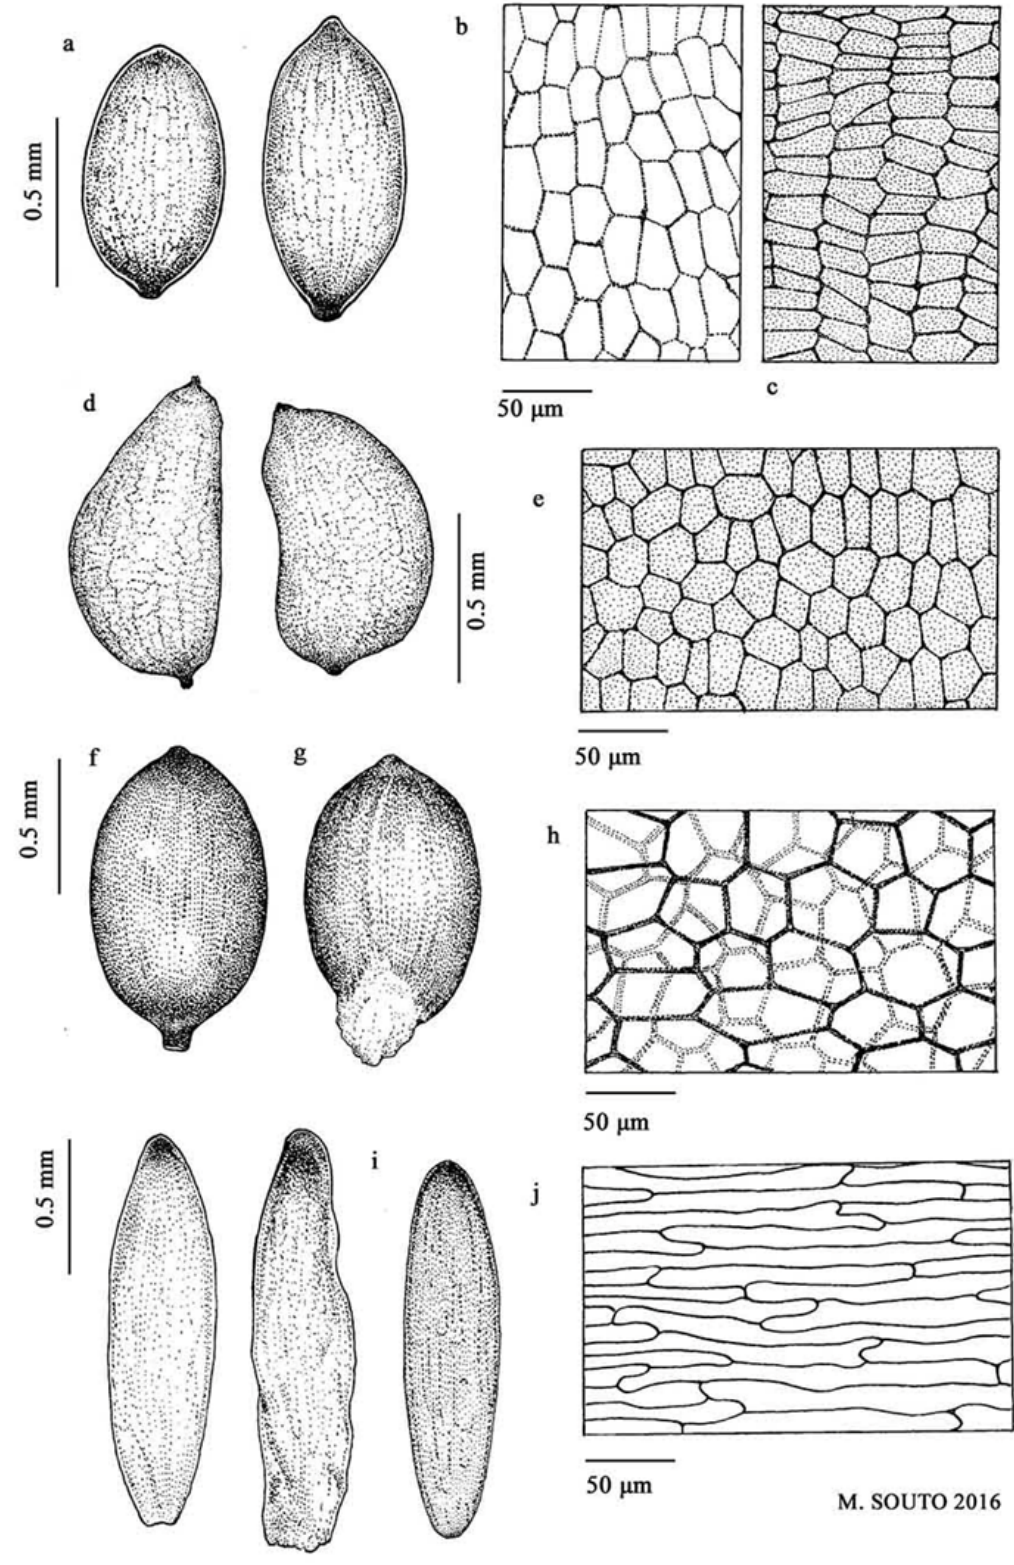
Figure A4. Juncus bulbosus : a) seeds; b) seed testa epidermal cells (outer integument); c) seed testa epidermal cells (inner integument). Juncus squarrosus : d) seeds; e) seed testa epidermal cells (inner integument). Luzula multiflora : f) seed; g) seed with remains of the elaiosome; f) seed testa epidermal cells. Narthecium ossifragum : i) seeds without testa (the outer cover is tegmen); j) tegmen epidermal